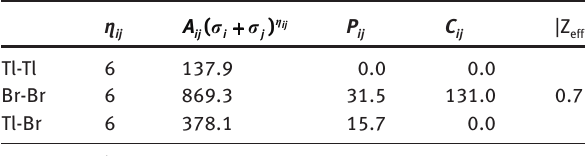
Table 2: The values of parameters of potential for